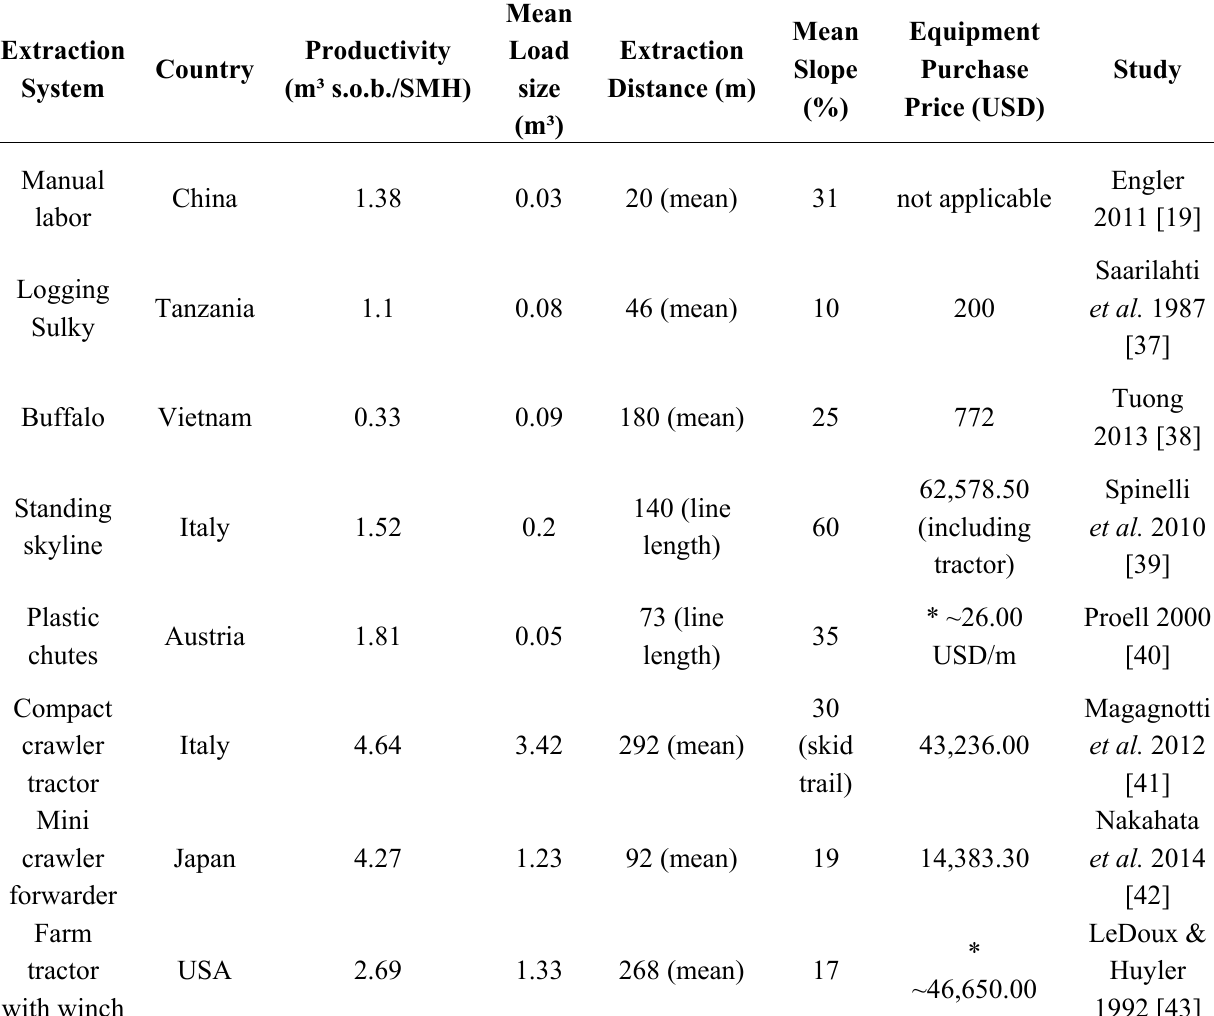
Table 8. Productivity studies of various extraction systems in small sale forestry